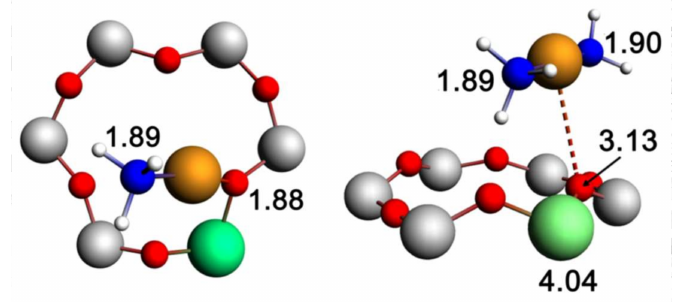
Figure 9. Local Cu environments after adsorption of one ( left ) and two ( right ) NH 3 molecules. Color code: orange, Cu; green, Al; gray, Si; red, O; blue, N; white, H. Distances between Cu and neighboring atoms are indicated in angstroms. Reprinted with permission from J. Phys. Chem. Lett. , 2014 , 5 , 1552–1559. Copyright 2014, American Chemical